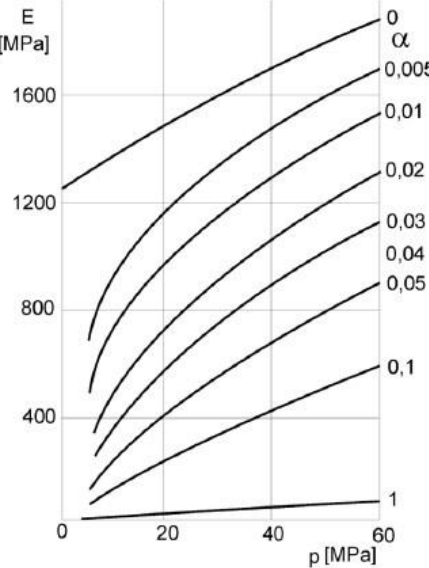
Fig. 6. The bulk modulus B of the mixture of diesel oil and gas, α – rela- tive gas volume in the pumping chamber, p – pressure